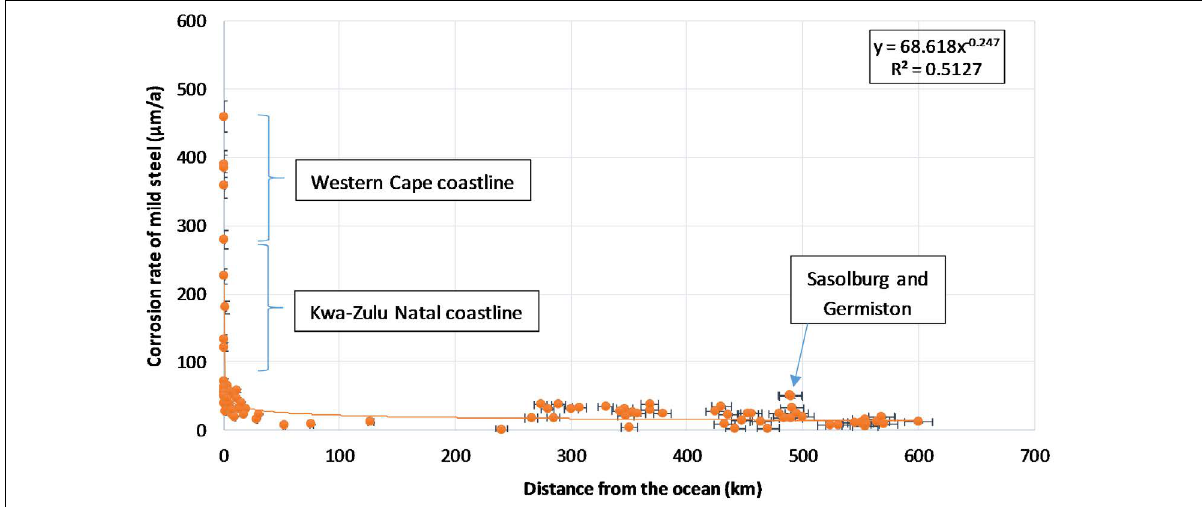
Figure 4: First-year (12-month) corrosion rates of mild steel, measured at numerous sites in South Africa, versus the approximate distances of the sites from the ocean.